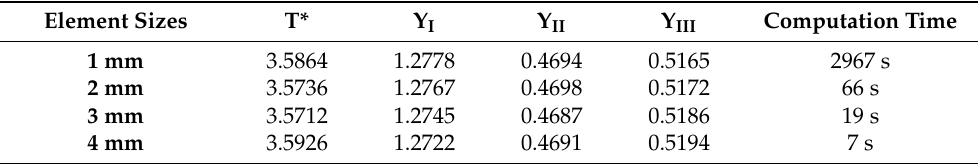
Table 1. Dimensionless T-stresses and SIFs for the finite element model of the TPB-IC specimen of different element sizes when a/W = 0.5, α = 30 ◦ and β = 30 ◦ . Element Sizes